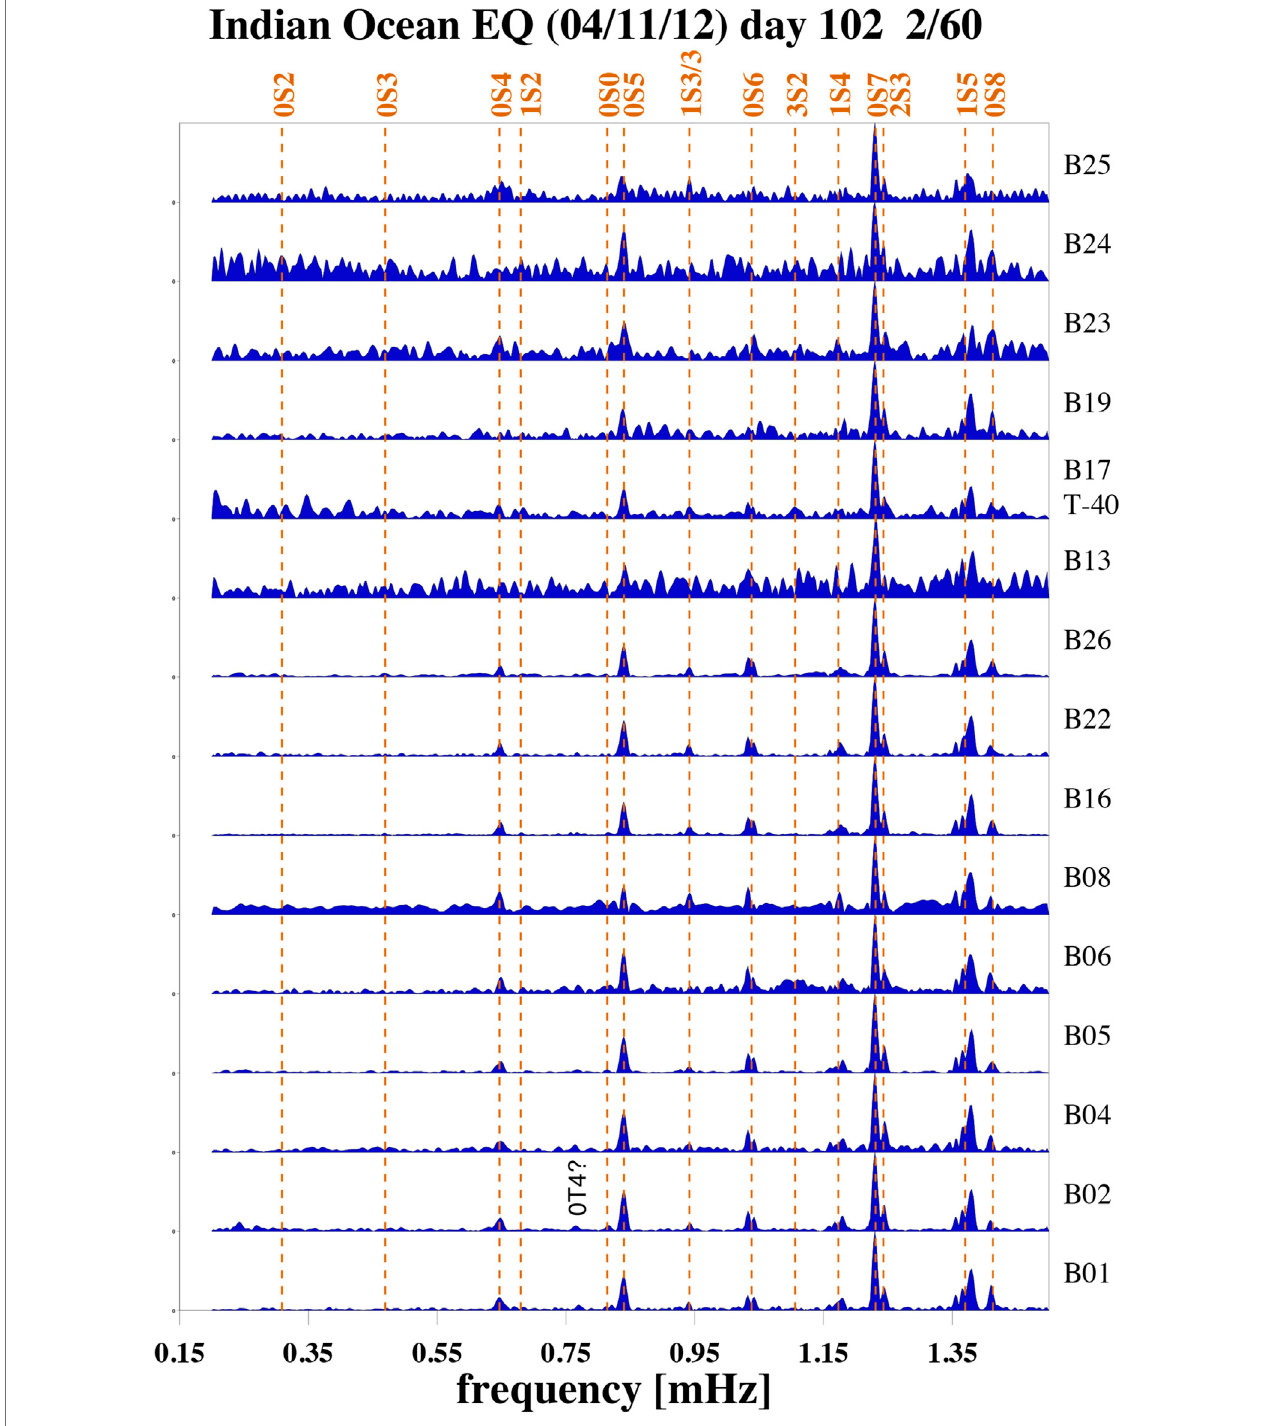
FIGURE 11 | Normalized raw vertical-component spectra for the April 11, 2012 Indian Ocean earthquake of 60-hour long segments, starting 2 h after the event time. See Supplementary Table S1 in the supplement for earthquake parameters. Site B17 featured a Nanometrics Trillium T-40 wideband sensor.